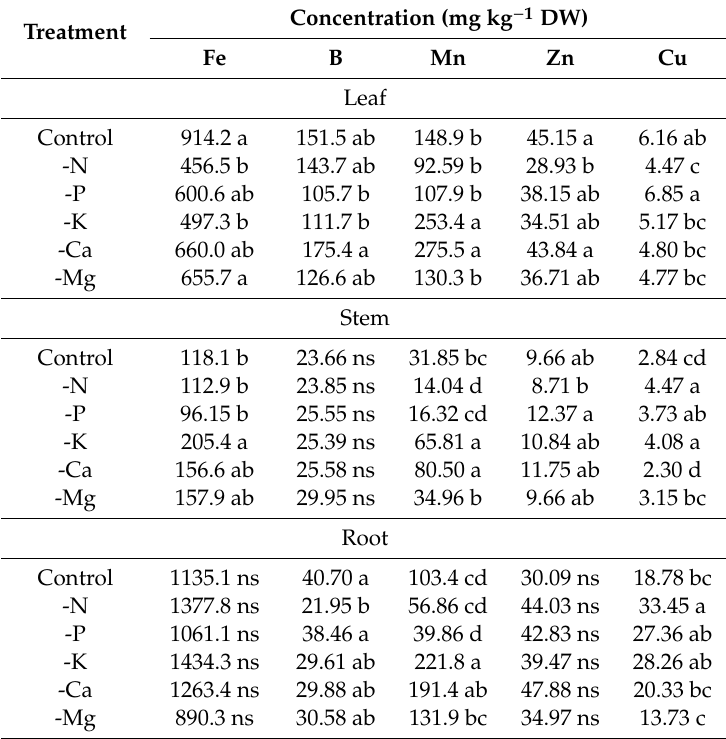
Table4. ContentofFe,B,Mn,Zn,andCuinleaf,stemarootoffigtreeplantswithmacronutrientdeficiency.